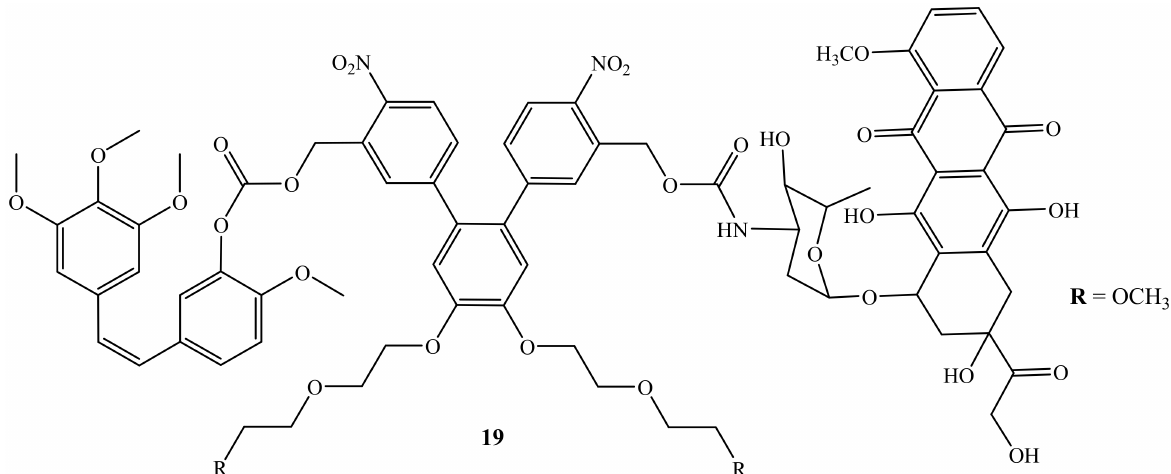
Figure 15. Chemical structure of doxorubicin combined with combretastatin A4 via the amino group ( 19 ).